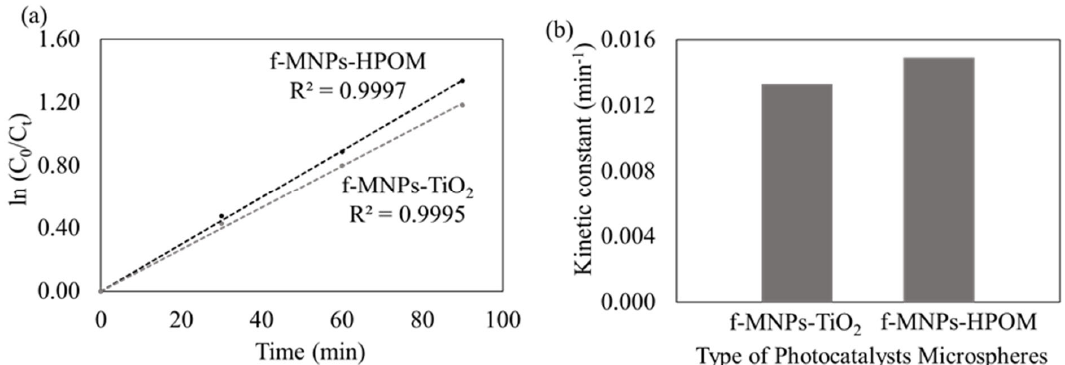
9 of 14 Figure 5. ( a ) UV ‐ visible diffusion reflectance of the spectrum and ( b ) plots of ( α hv) 2 vs. energy of HPOM. The photocatalytic degradation kinetics of MO were investigated to gain insight into the reactive kinetic behavior of MO degradation in the photocatalyst microspheres. The kinetic curves of MO degradation using either photocatalyst microsphere are well ‐ fitted to the Langmuir–Hinshelwood pseudo ‐ first ‐ order kinetic model (R 2 > 0.99), wherein